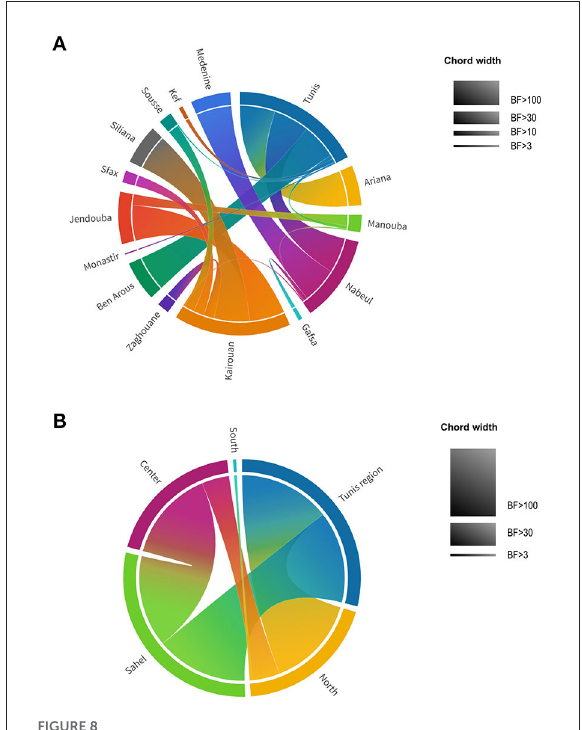
FIGURE8 Chord diagram of theAY.122 SARS-CoV-2 variant representing Bayes Factor (BF) of transitions between different locations in Tunisia. (A) BF of transitions between Tunisian governorates. (B) BF of transitions between Tunisian regions. Tunisian governorates and regions are presented by different colors. Chord width is proportional to BF support levels: BF < 3 no support, BF > 3 substantial support, BF > 10 strong support, BF > 30 very strong support, BF > 100 decisive